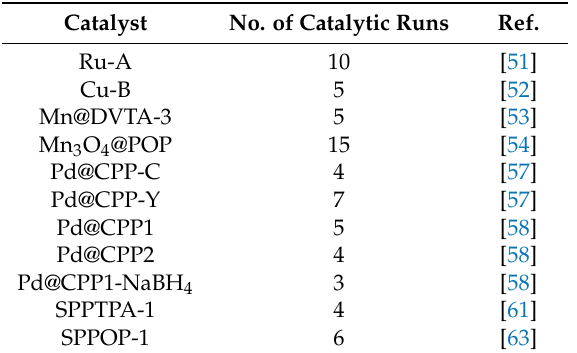
Table 5. Recyclability and reusability of metal encapsulated and functionalized POPs.